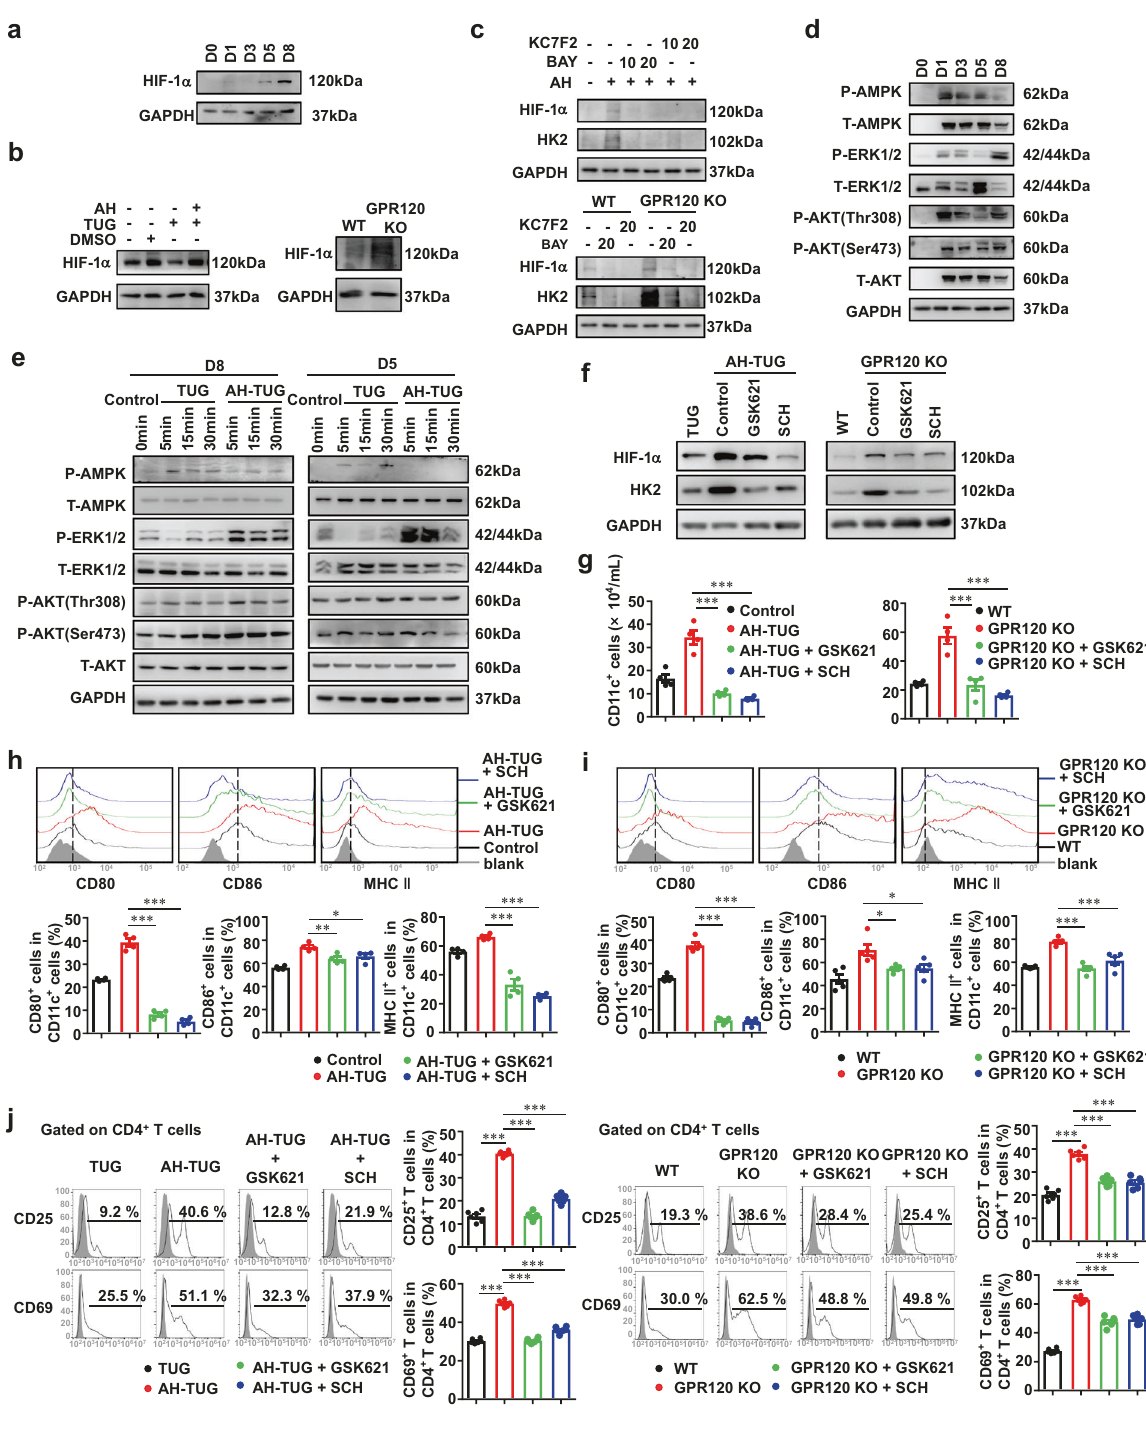
8b). These results indicated that the expression of GPR120 could not indicate the progression of FHF. We speculated that levels of the ligands of GPR120, such as saturated (C14 – C18) and unsaturated (C16 – C22) FFAs, may indicate the activation state of GPR120 and correlate with the severity of FHF. Thus, the levels of FFAs in the plasma of HC and FHF patients were analyzed. As shown in Fig. 8c, the amounts of total FFAs (C14 – C22) in the plasma of FHF patients was signi fi cantly lower than those in HC. MELD is the most